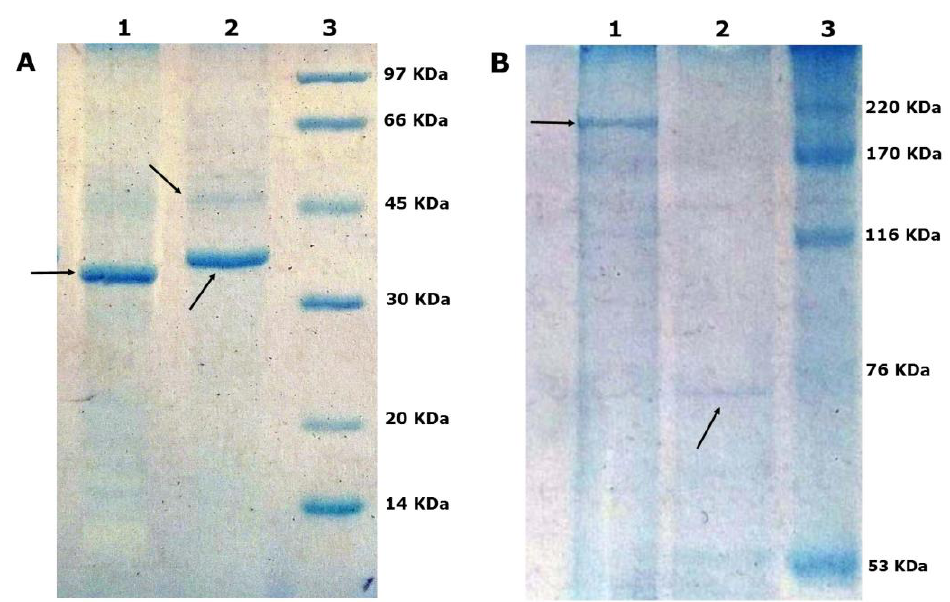
Figure 1. Coomassie blue dye stained SDS-PAGE gels showing the outer membrane proteins, (1) Xenorhabdus nematophila , (2) Photorhabdus luminescens , (3) Standard. ( A ) The molecular weight 14–97 kDa, ( B ) The molecular weight 53–220 kDa. Protein fragments have shown with arrows.